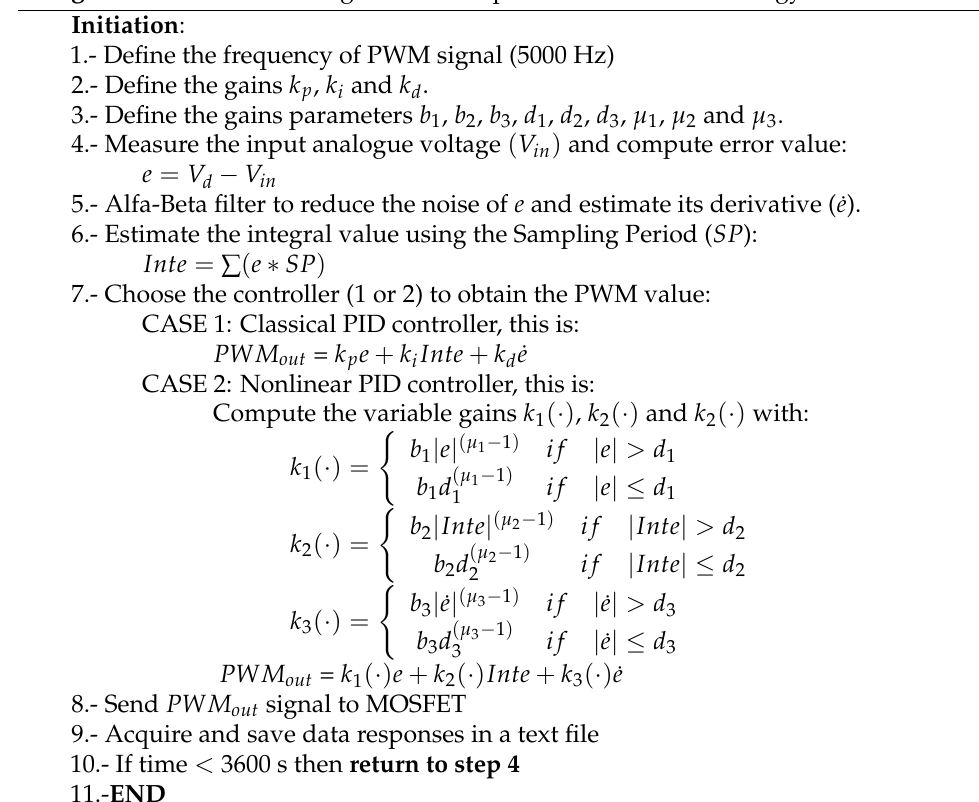
Algorithm 1: Embedded algorithm to implement the control